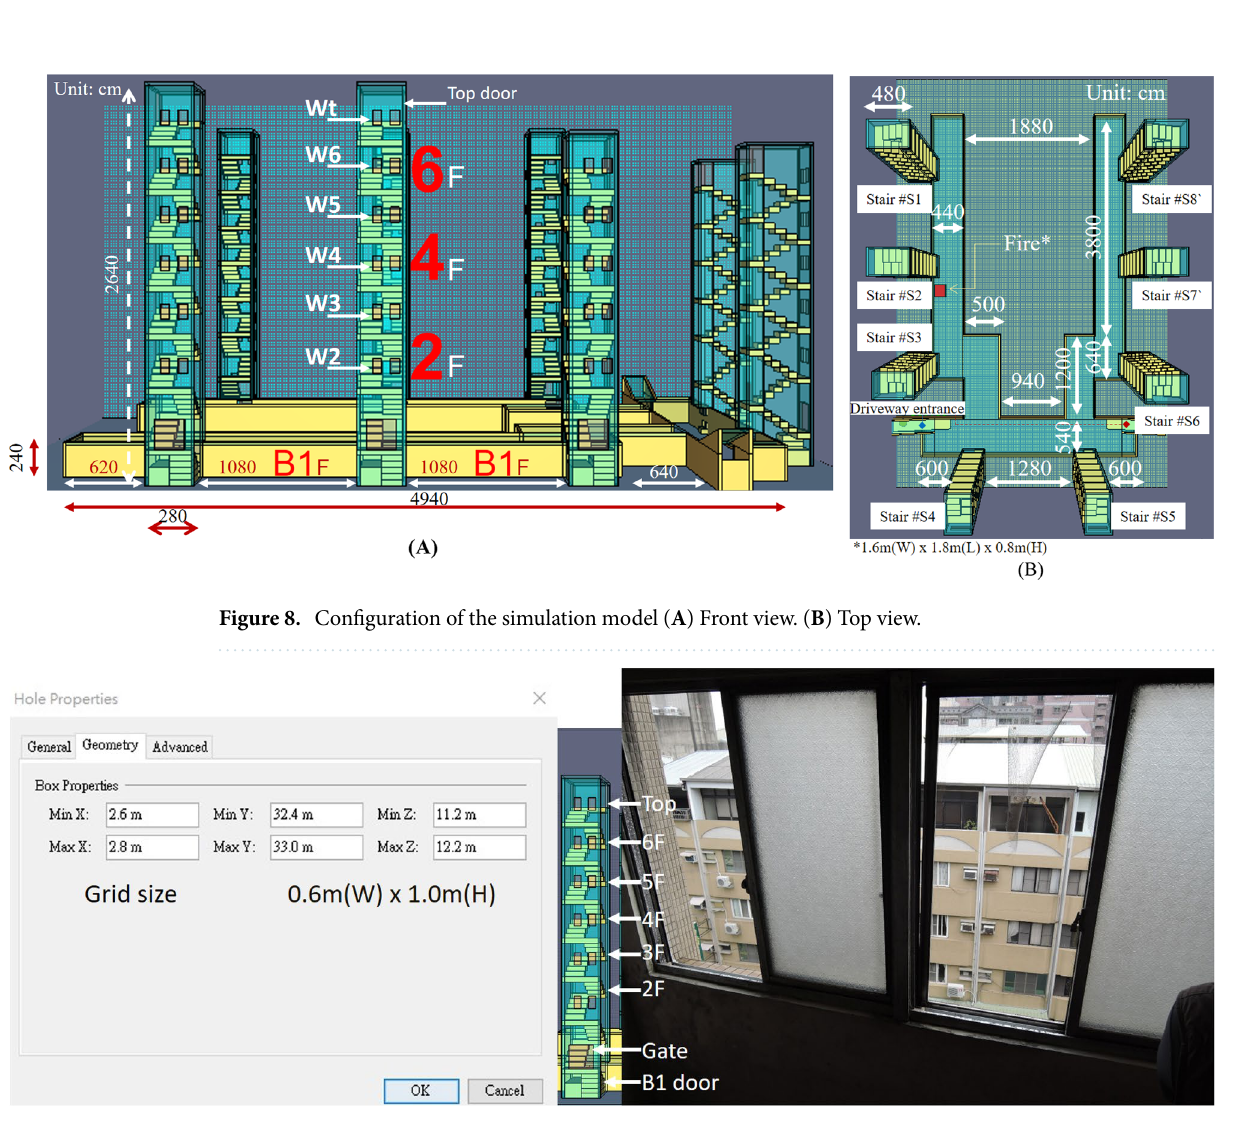
Figure 9. Setting value of parameters at the platform window of No. 2